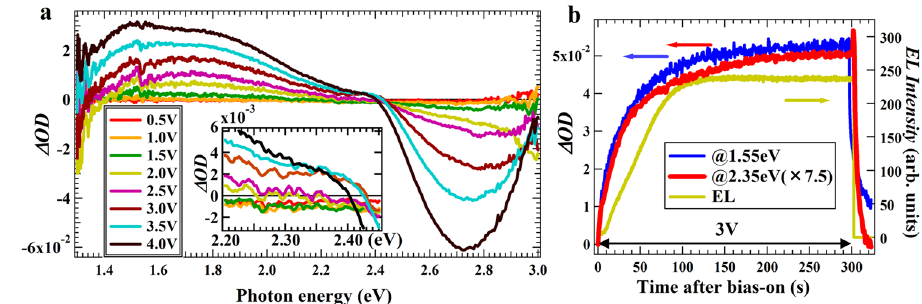
Fig.2|Bias-inducedspectroscopicsignalsinaslowtimeregime.a Bias-induced (BI) spectra obtained for the SY-LEC under steady-state bias application in 0.5V stepsfrom0.5Vto4.0V.Theinsetistheenlargedviewofspectrafrom2.2to2.4eV. These spectra were obtained by recording simultaneously the signals of the entire